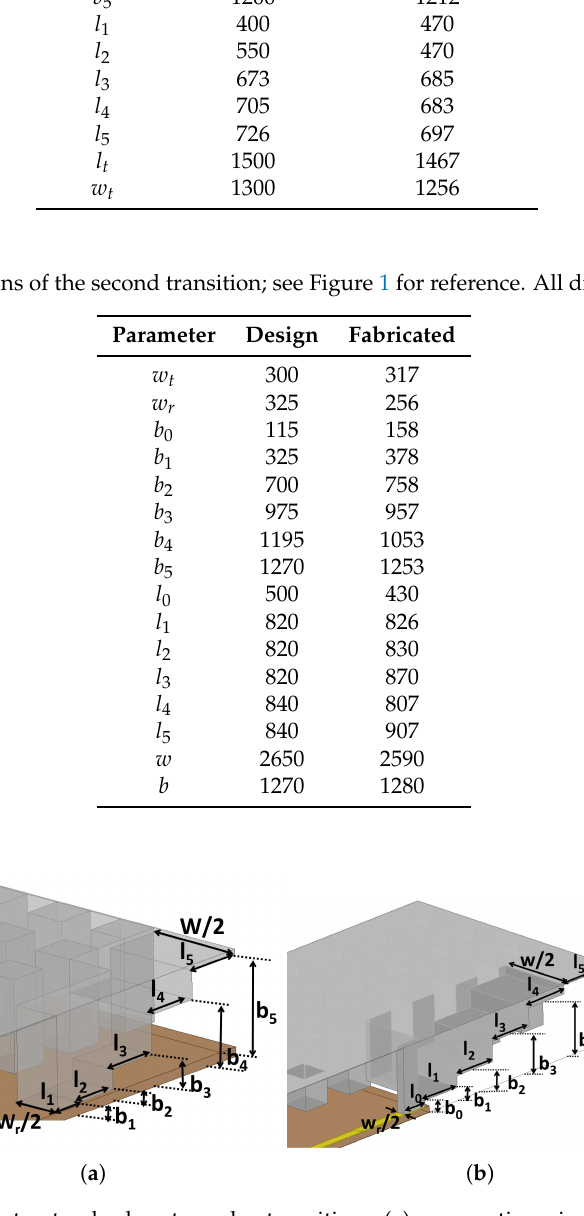
Figure 5. Microstrip to standard rectangular transition: ( a ) perspective view of the Chebyshev transformer split in half for the first model and ( b ) for the second